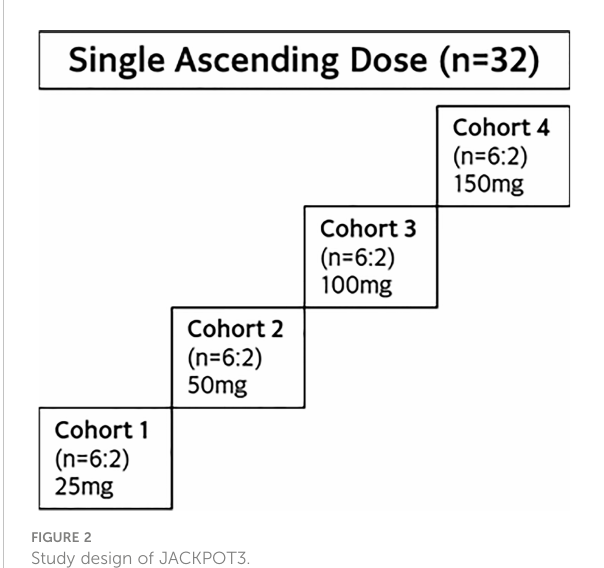
FIGURE 2 Study design of